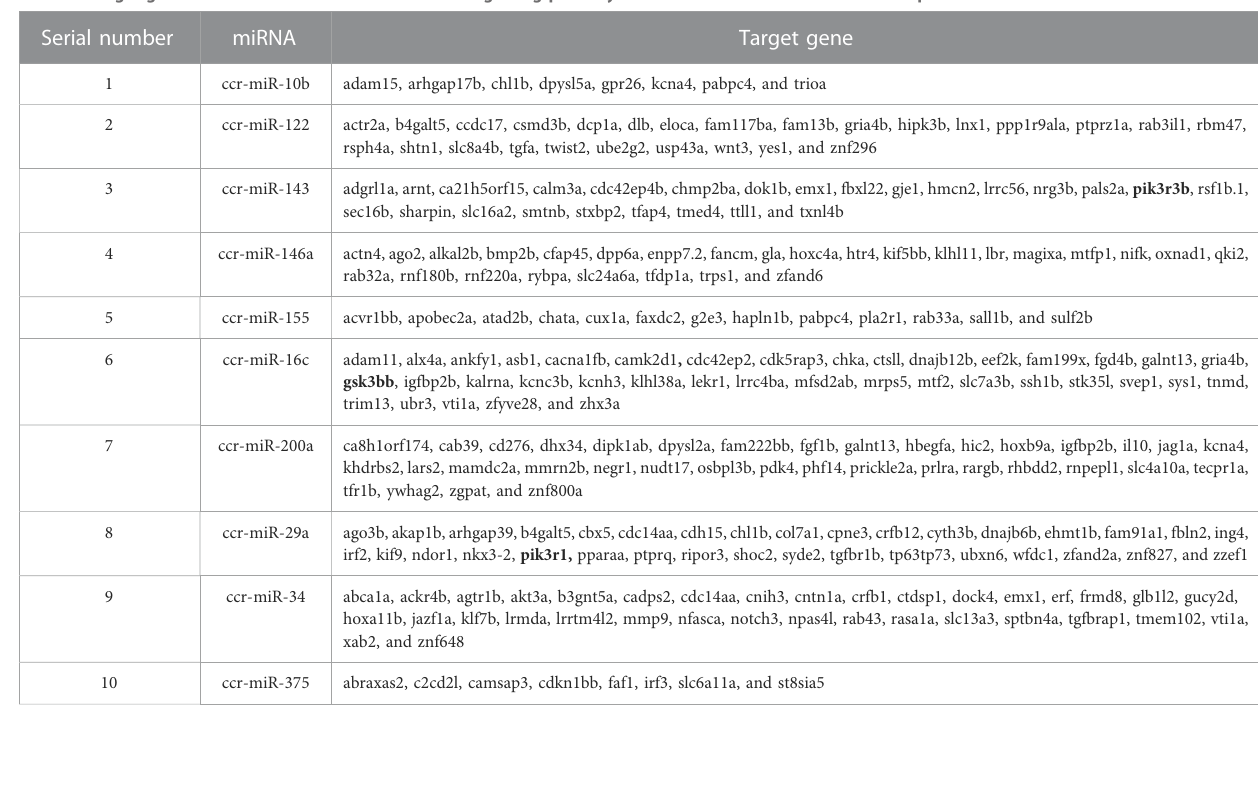
TABLE 6 Target genes of miRNAs associated with insulin signaling pathway and insulin resistance of common carp.